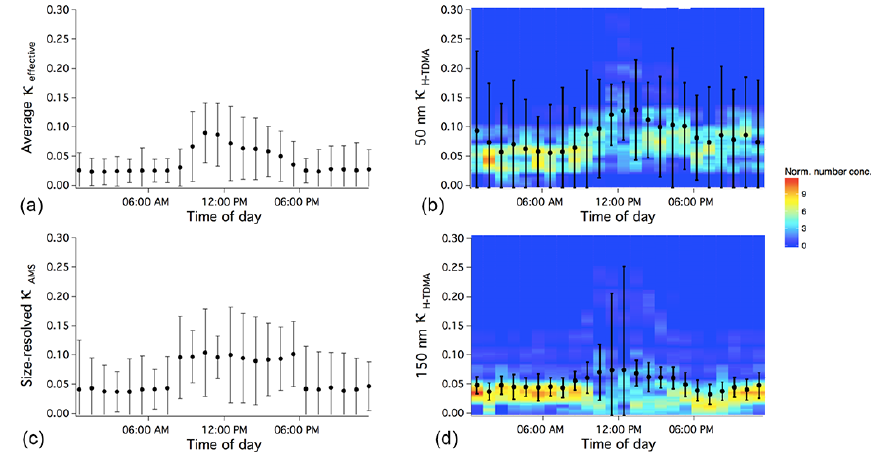
Figure 4. The diurnal trends of (a) the CCNC-derived effective hygroscopicity parameter, (b) the H-TDMA-derived kelvin-corrected hy- groscopicity distributions of 50nm particles, (c) the AMS-derived hygroscopicity parameter for aerodynamic diameters between 100 and 200nm, assuming κ org of 0.02 and 0.08 during the night and day, respectively, and (d) the H-TDMA-derived kelvin-corrected hygroscop- icity distributions of 150nm particles. The black dots in (b) and (d) represent the hourly median hygroscopicity values and the error bars represent the standard